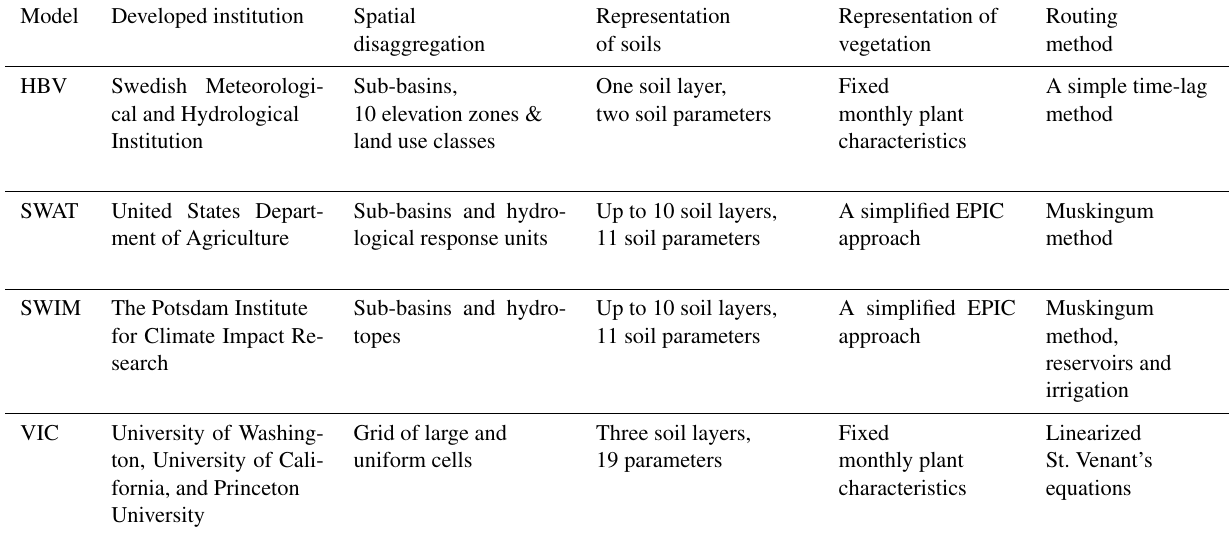
Table 2. Short description of HBV, SWAT, SWIM and VIC. Model